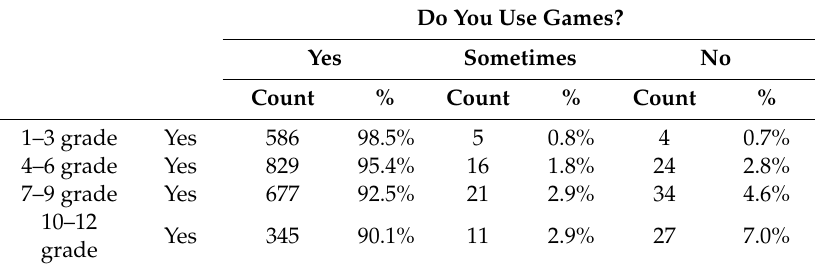
Table 4. Game use per grade level